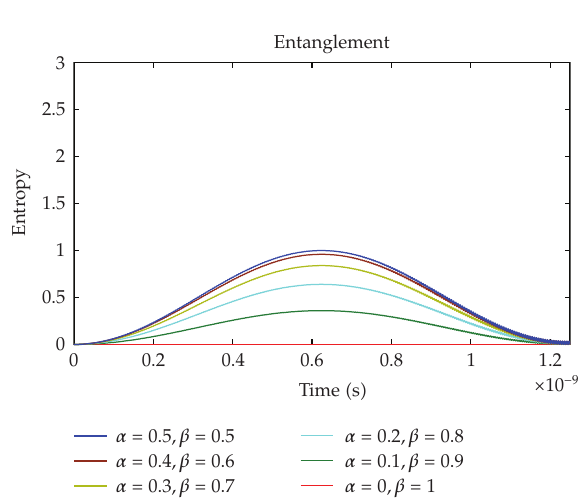
Figure 11: Spin-photon entanglement dynamics for large Δ .